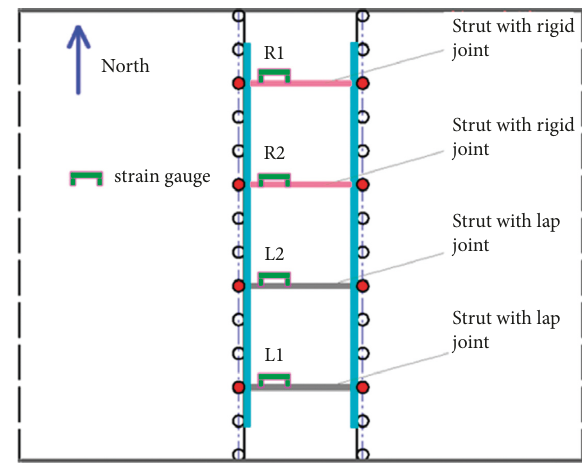
Figure 12: Strain gauge measuring point number of the first layer of steel strut.